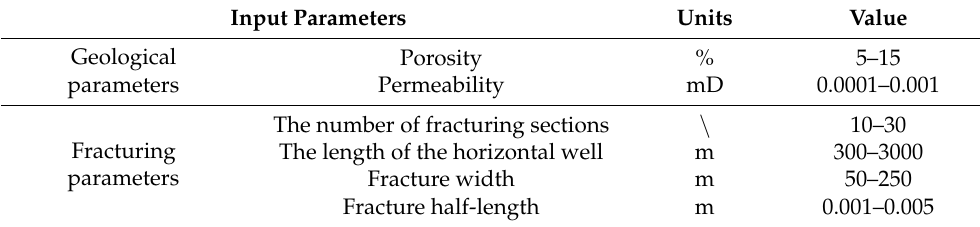
Table 2. The values of input parameters.